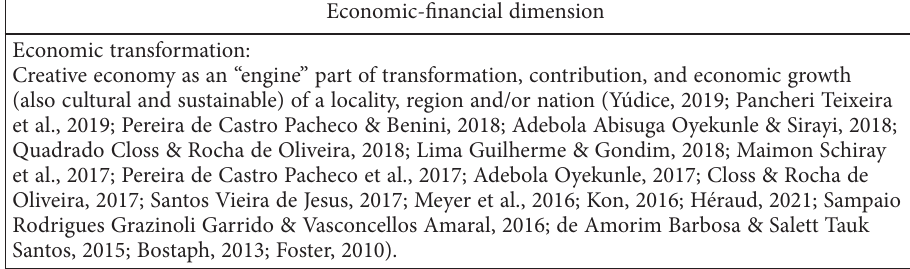
Table 4. Chart 3: dimensions and criticality factors of creative economy (source: created by authors) Economic-financial